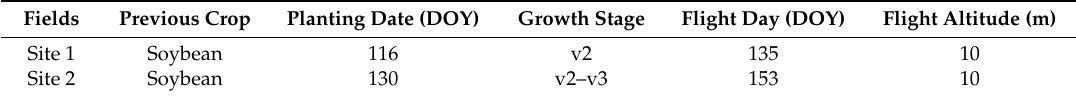
Table 1. Information about sites and flights during the 2017 growing